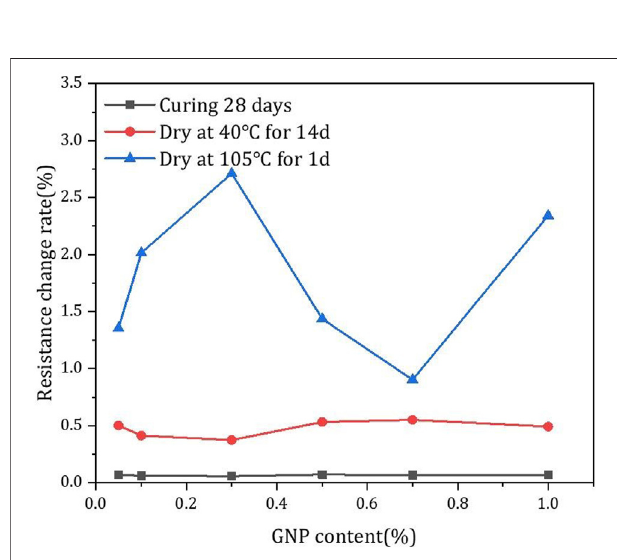
FIGURE8| TheeffectsofdryingconditionsandtheGNP-C-500content on resistance change rate.